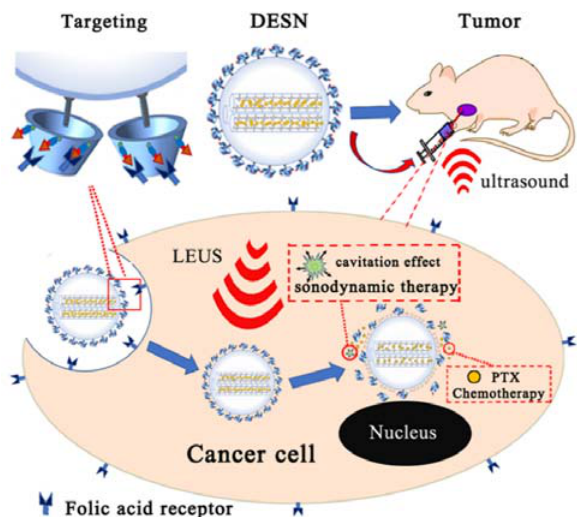
Scheme 2. Schematic illustration of the process of killing tumor cells by DESN-mediated dual-model